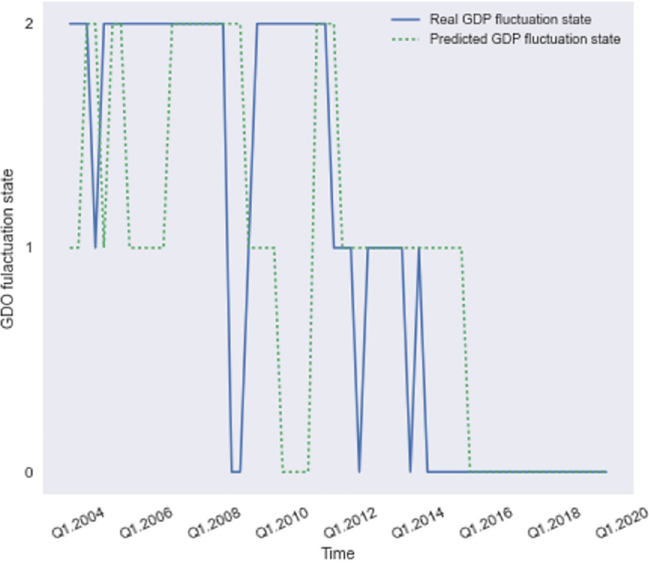
Fig 7. The predictions of GDP fluctuation states using HMM(q) within 4-year time window.